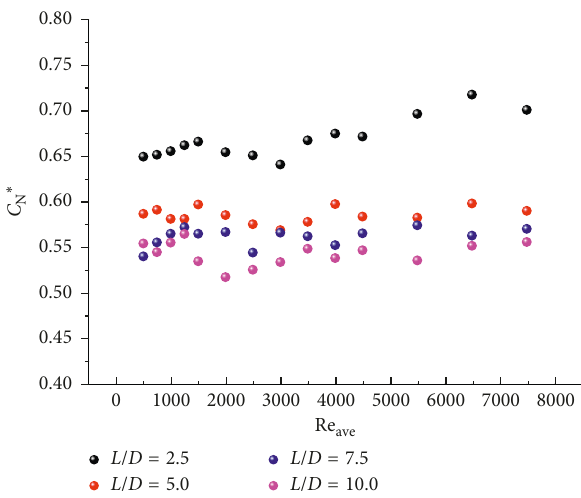
Figure 8: Normalized north outlet concentration C ∗ ferent L / D for varied average Reynolds number at double-Tee